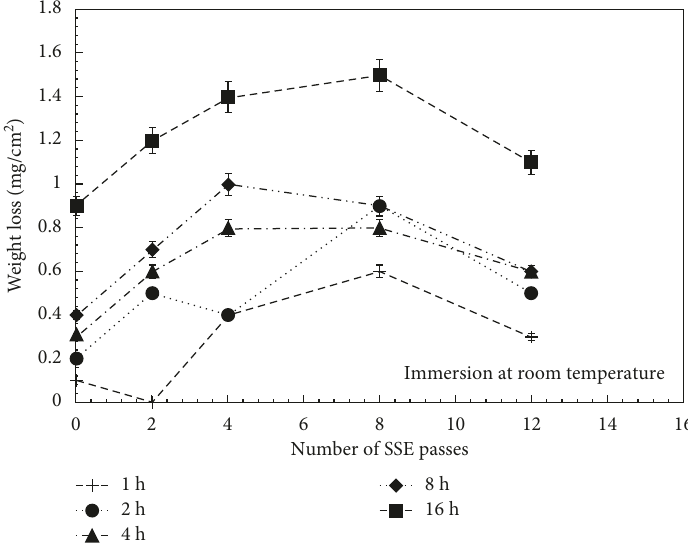
Figure 4: The weight loss of SSE-processed samples measured by the immersion tests in the modified Livingston etchant for 1, 2, 4, 8, and 16